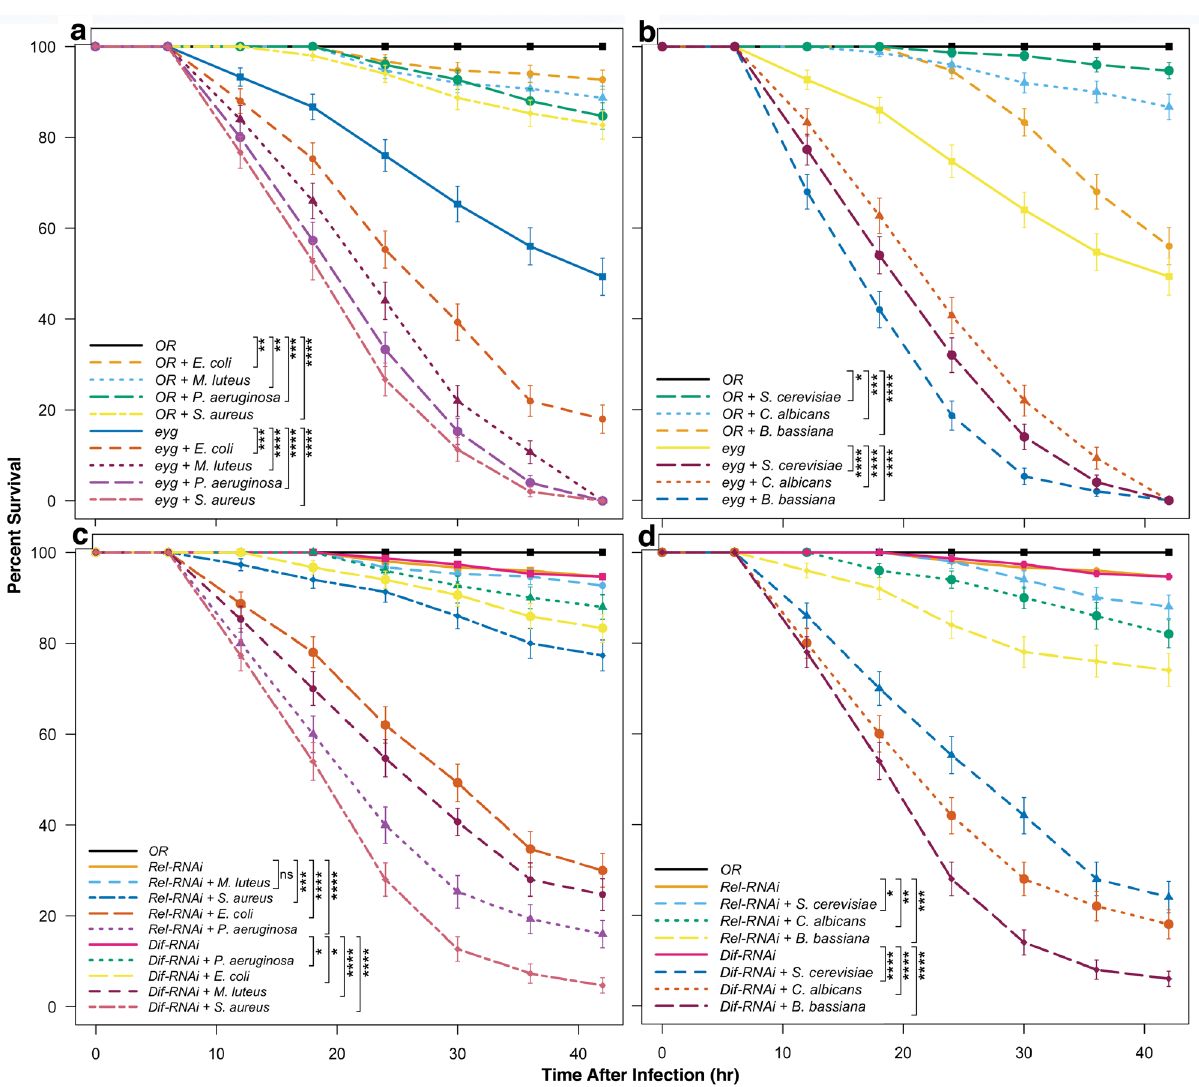
Figure 3. Pupae unable to deliver an apocrine secretion or with impaired Dif or Rel signaling during the late- larval and prepupal period are more susceptible to microbial infection. Mutant eyg C1 / eyg C53 pupae, who lack a SG duct to deliver the apocrine secretion, show reduced survival when challenged with Gram-negative ( E . coli and P . aeruginosa ) or Gram-positive ( M . luteus and S . aureus ) bacteria ( a ) or when challenged with yeasts or fungi ( S . cerevisiae , C . albicans and B . bassiana ) ( b ). Pupae with impaired Dif ( Sgs4 - Gal4 > > UAS - Dif RNAi ) or Rel ( Sgs4 - Gal4 > > UAS - Dif RNAi ) signaling show reduced survival when challenged with Gram-negative ( E . coli and P . aeruginosa ) or Gram-positive ( M . luteus and S . aureus ) bacteria ( c ). Pupae with compromised Rel expression are more sensitive to Gram-negative than Gram-positive bacteria, while those with compromised Dif expression are more sensitive to Gram-positive than Gram-negative bacteria. ( d ) Pupae with impaired Dif or Rel signaling have diminished survival when challenged with yeasts or fungi ( S . cerevisiae , C . albicans and B . bassiana ). Data shown are the means ± SEM of three independent experiments. Differences in survival were evaluated using the Mantel-Cox log-rank test: ns = not significant, * p < 0.05, ** p < 0.001, *** p < 1 × 10 –5 , **** p < 1 × 10 –10